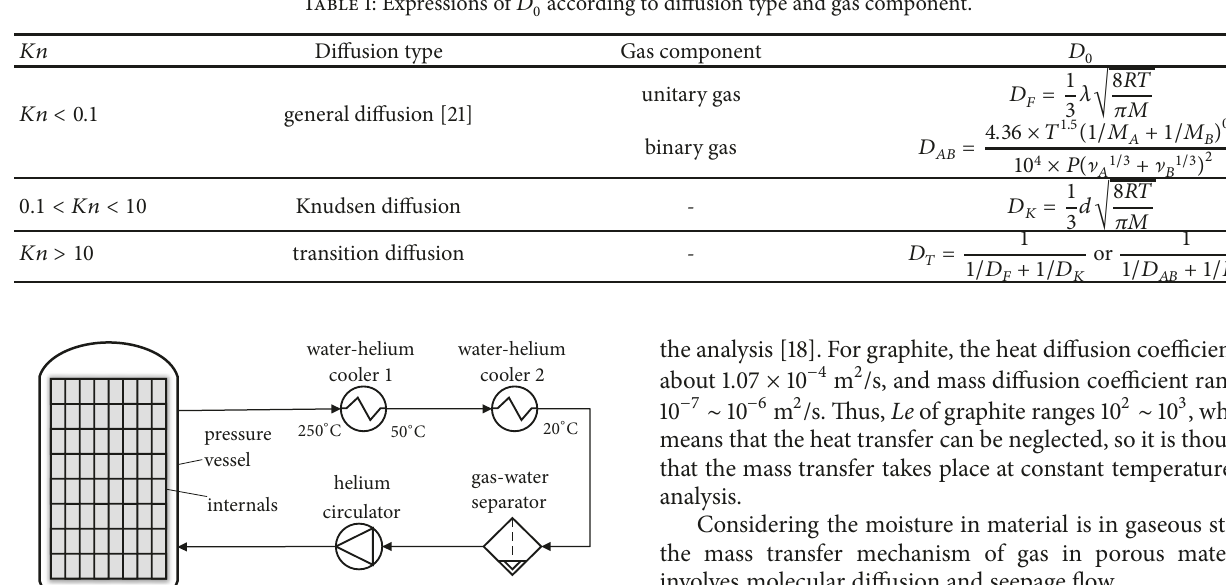
Table 1: Expressions of 𝐷 0 according to diffusion type and gas component.